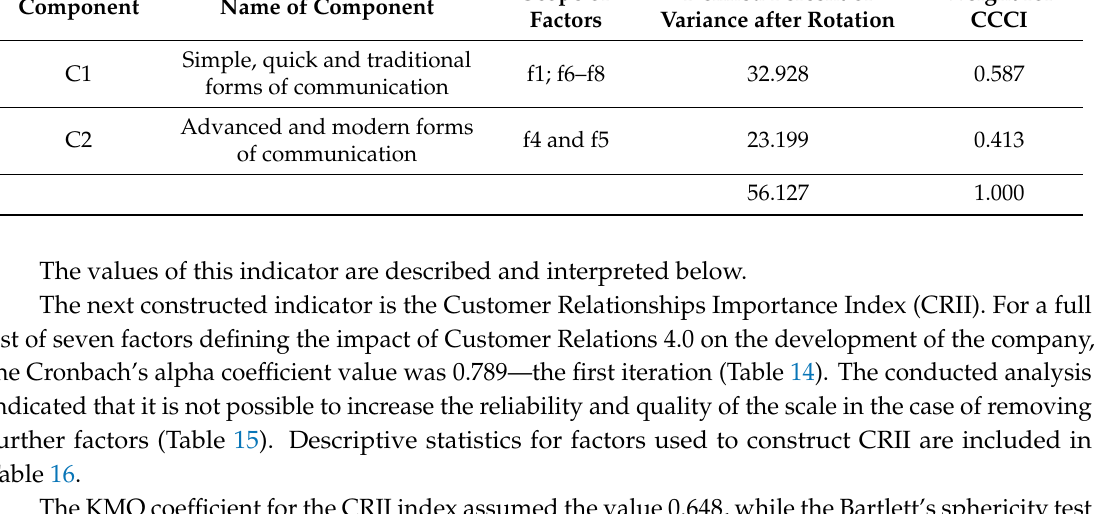
Table 13. Two main components of Customer Communication Complexity Index. Component